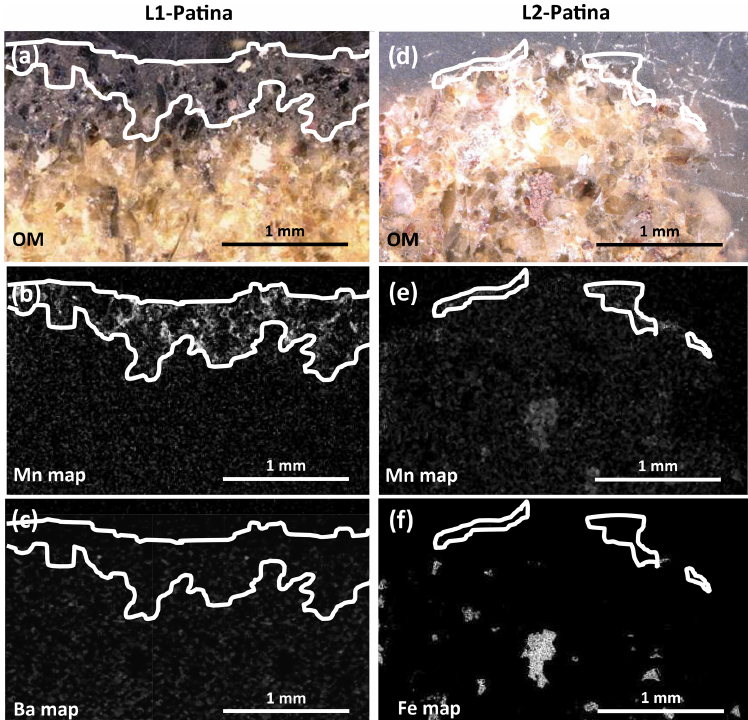
Figure 6. Optical images (a, d) and EDS maps (b, c, e, f) obtained on selected zones of L1 (a, b, c) and L2 (d, e, f) surfaces with patina. Areas in white outline extension of Mn-rich patinas. In the chemical maps, bright areas indicate high elemental concentrations (Mn: b, e ; Ba: c ; Fe: f